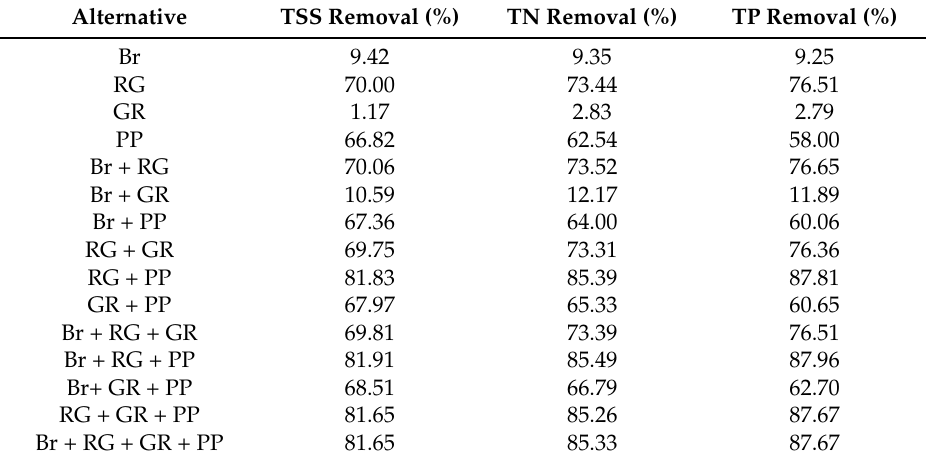
Table 7. Pollutant removal rates